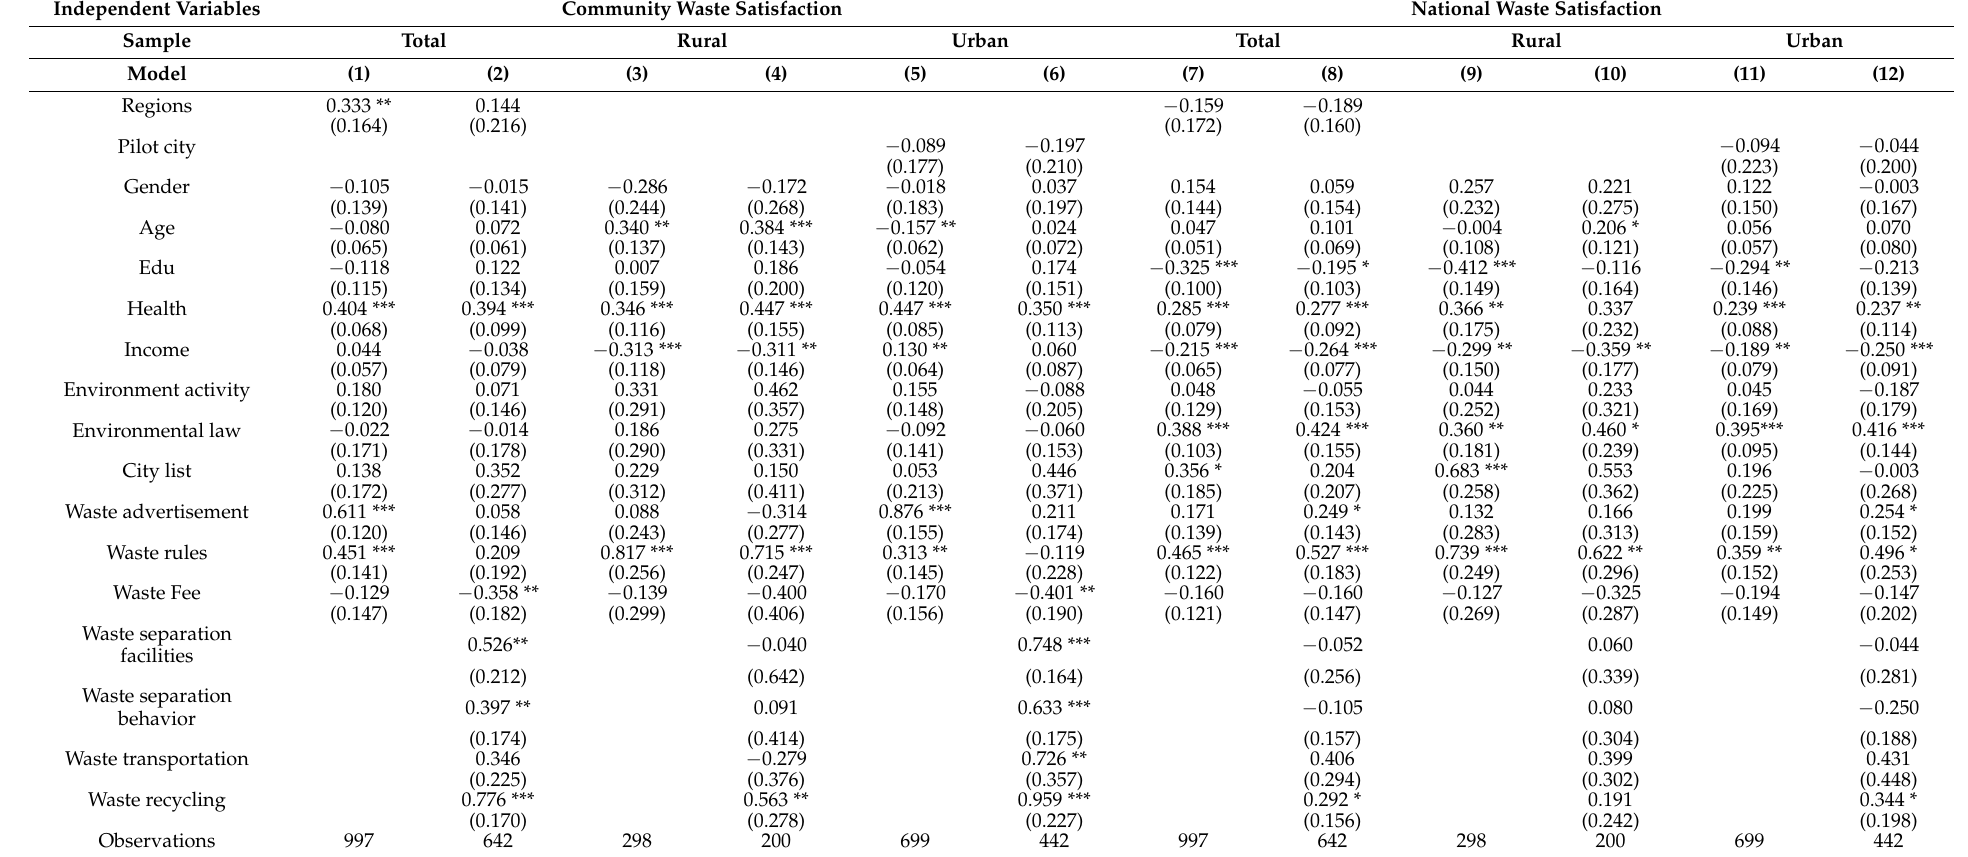
Table 4. Determinants of satisfaction with communities and national SWMS in